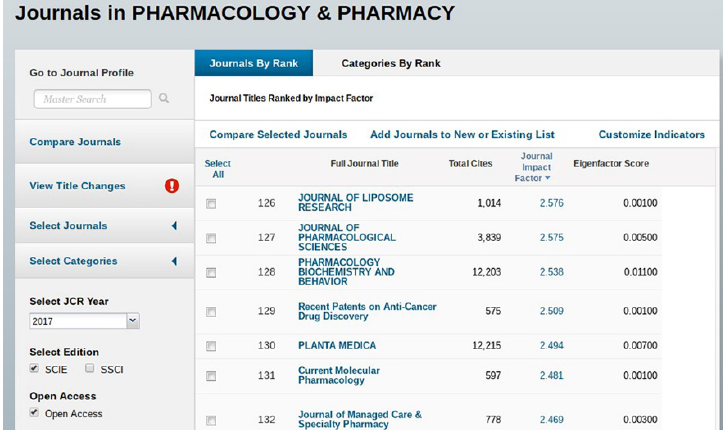
Figure 2 JCR list of journals in pharmacology and